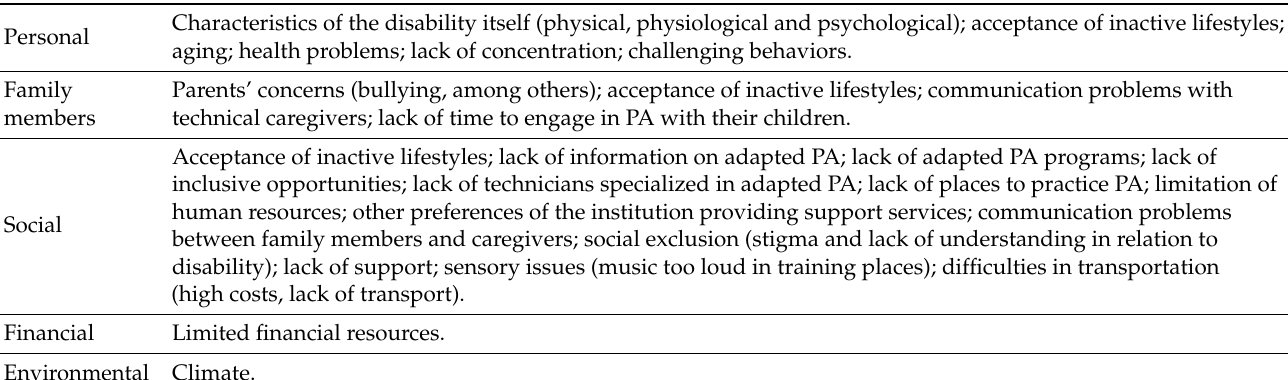
Table 2. Barriers to PA practice divided by different